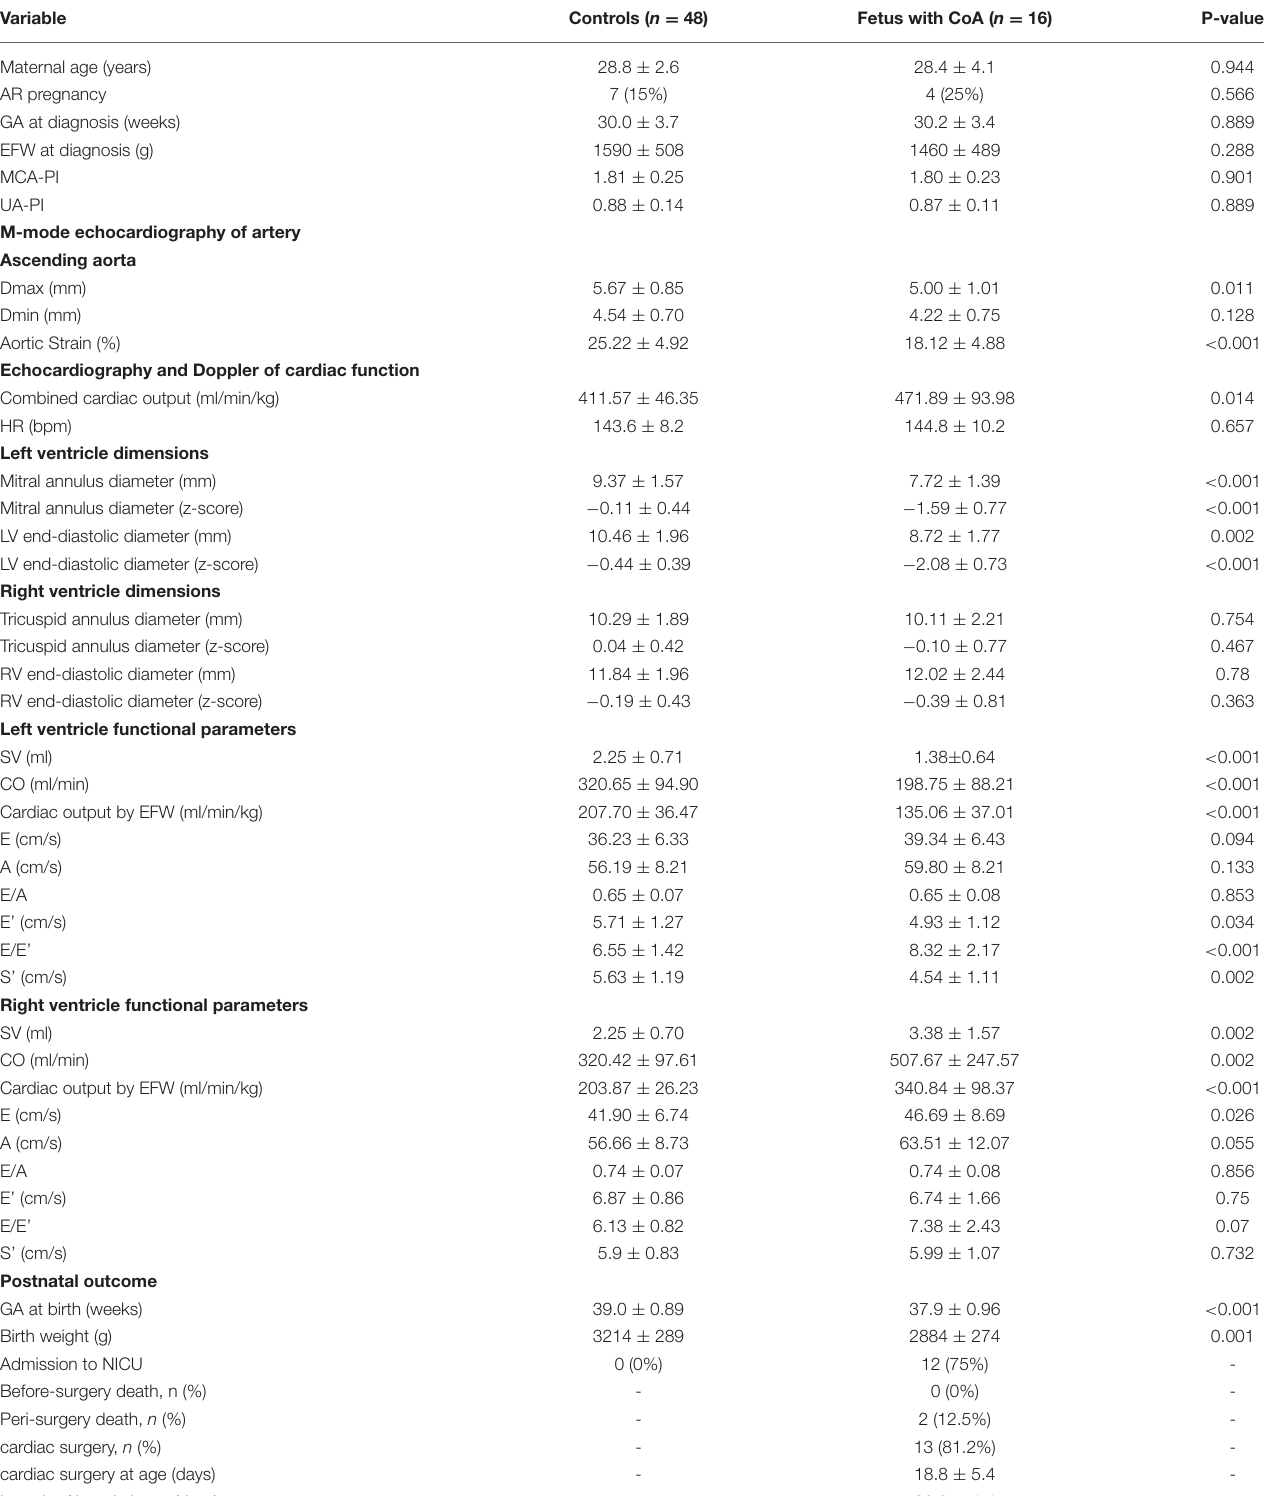
TABLE 1 | Clinical data and Echocardiography of artery and cardiac function in the controls and fetuses with CoA.